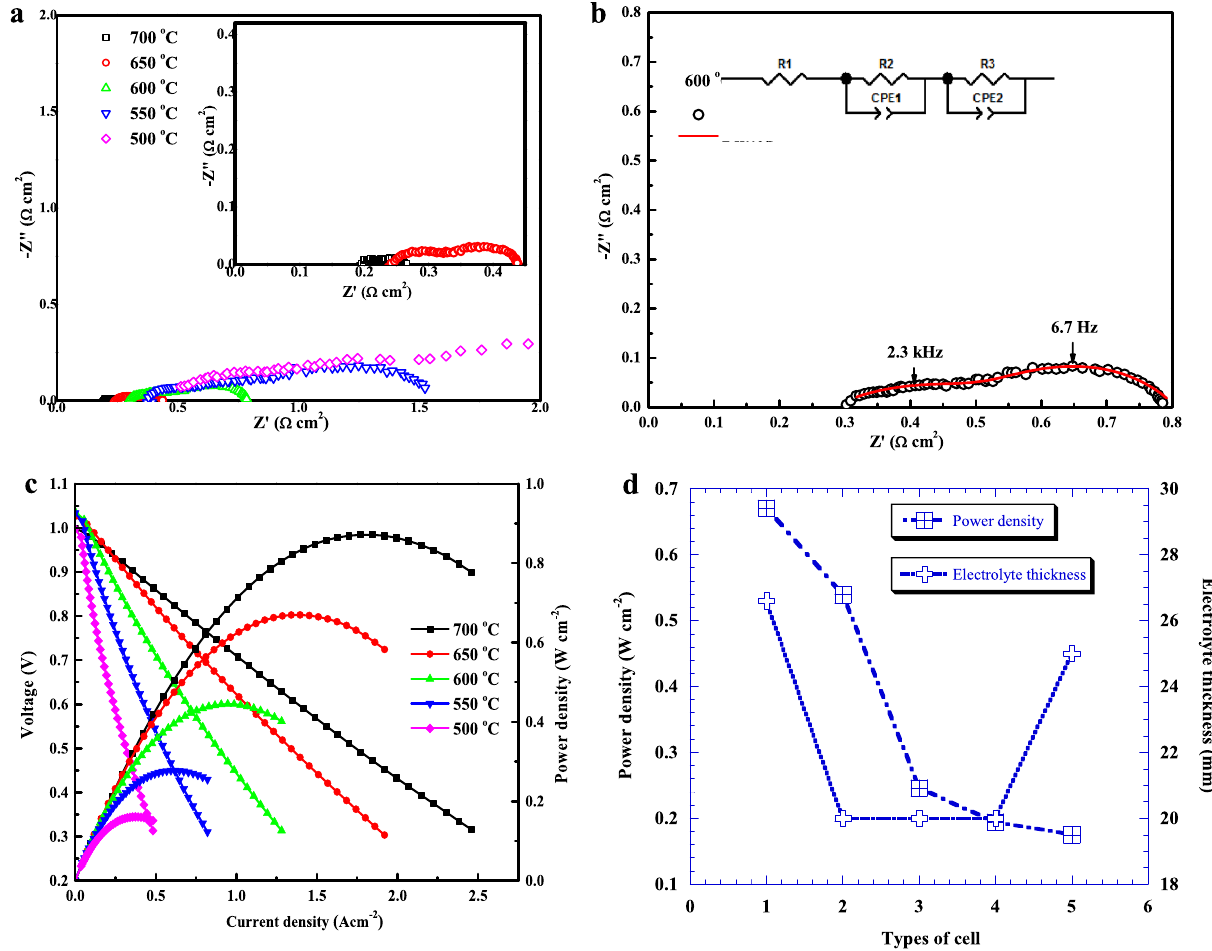
Figure 3. Electrochemical properties of NiO-BCZYZn05|BCZYZn05|BSCF-BCZYZn05 single cells. ( a ) Electrochemical impedance spectra collected at 500–700 °C in 50 °C intervals. ( b ) Fitted Nyquist impedance plot at 600 °C, which shows two semicircles; the equivalent circuit is shown in the insert. ( c ) I–V and power- density curves of the BCZYZn05-based fuel cell using humidified H 2 (3% H 2 O) as the fuel and ambient air